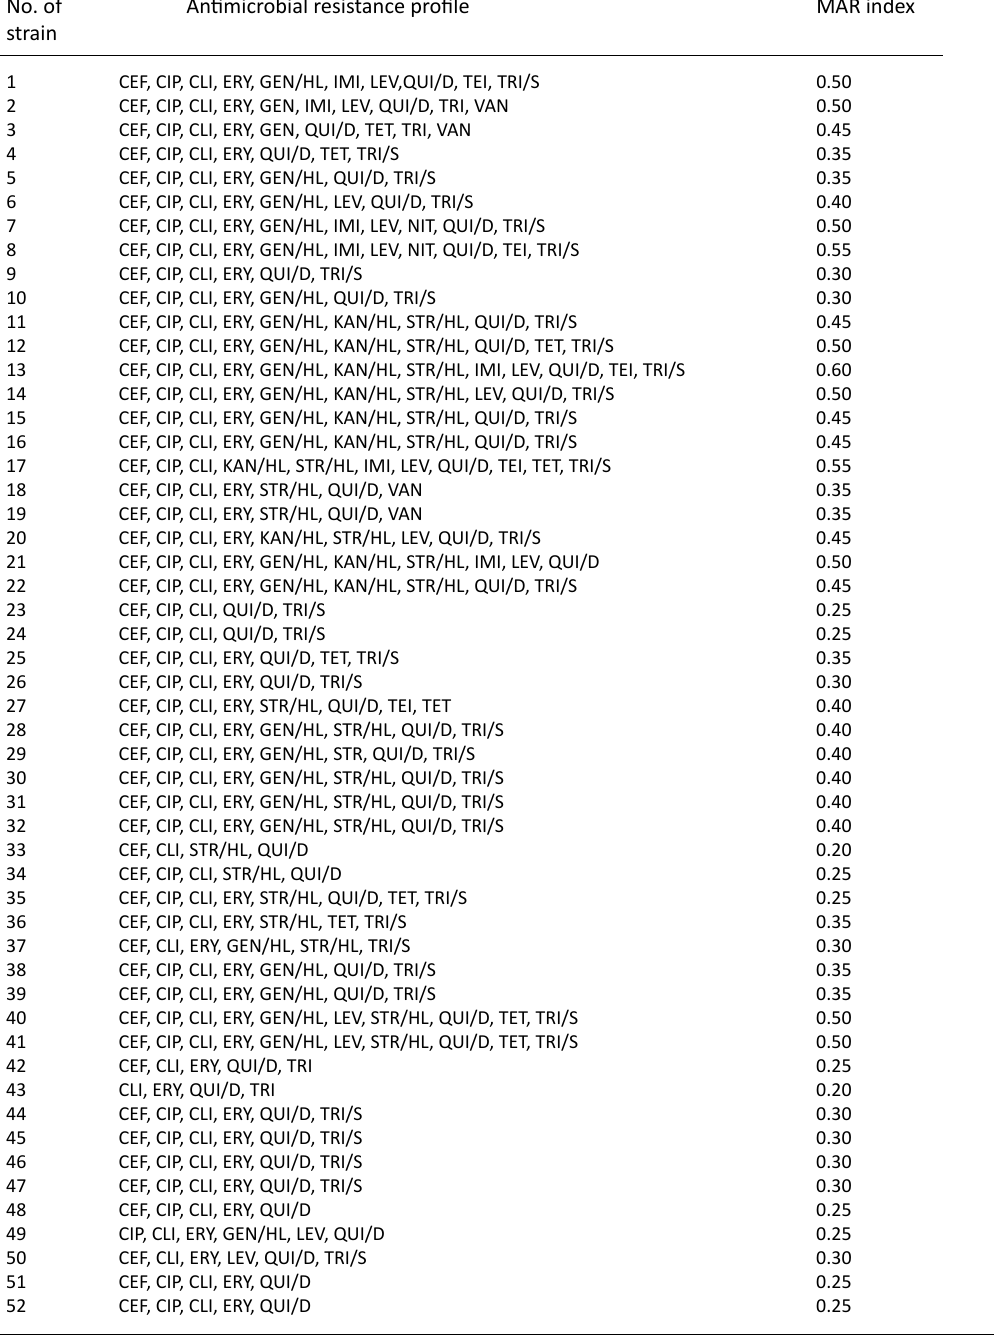
Table 3. Multi antibiotic resistance (MAR) patterns distribution among 52 E. faecalis isolates No. of Antimicrobial resistance profile MAR index